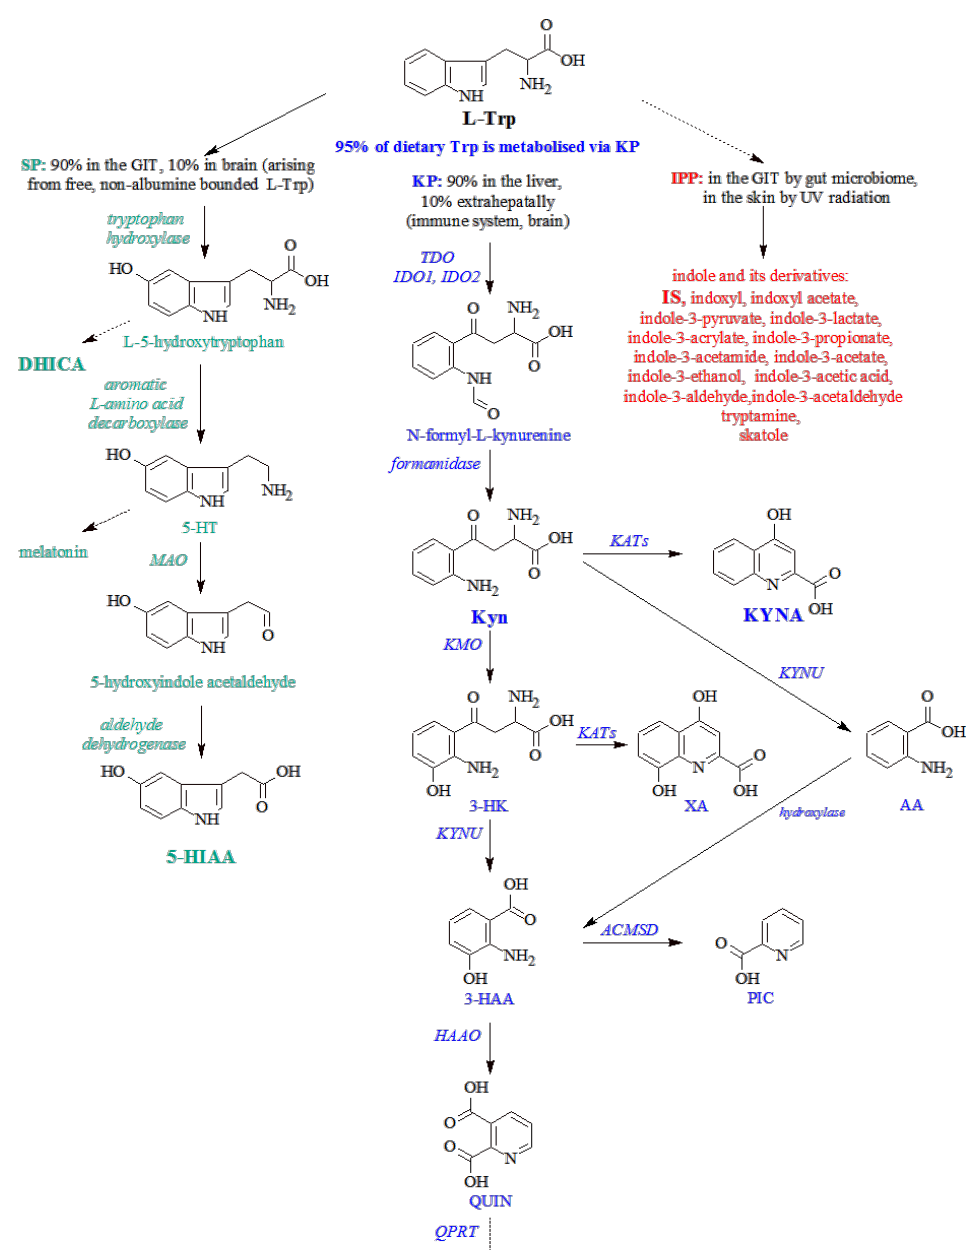
Figure 1. The three pathways of tryptophan metabolization are the kynurenine pathway, serotonin pathway, and the indole pathway. KP—kynurenine pathway, SP—serotonin pathway, IPP—indole pyruvate pathway; L-Trp—L-tryptophan, Kyn—kynurenine, 3-HK—3-hydroxykynurenine, 3-HAA—3-hydroxyanthranilic acid, QUIN—quinolinic acid, NAD + —nicotinamide adenine din-